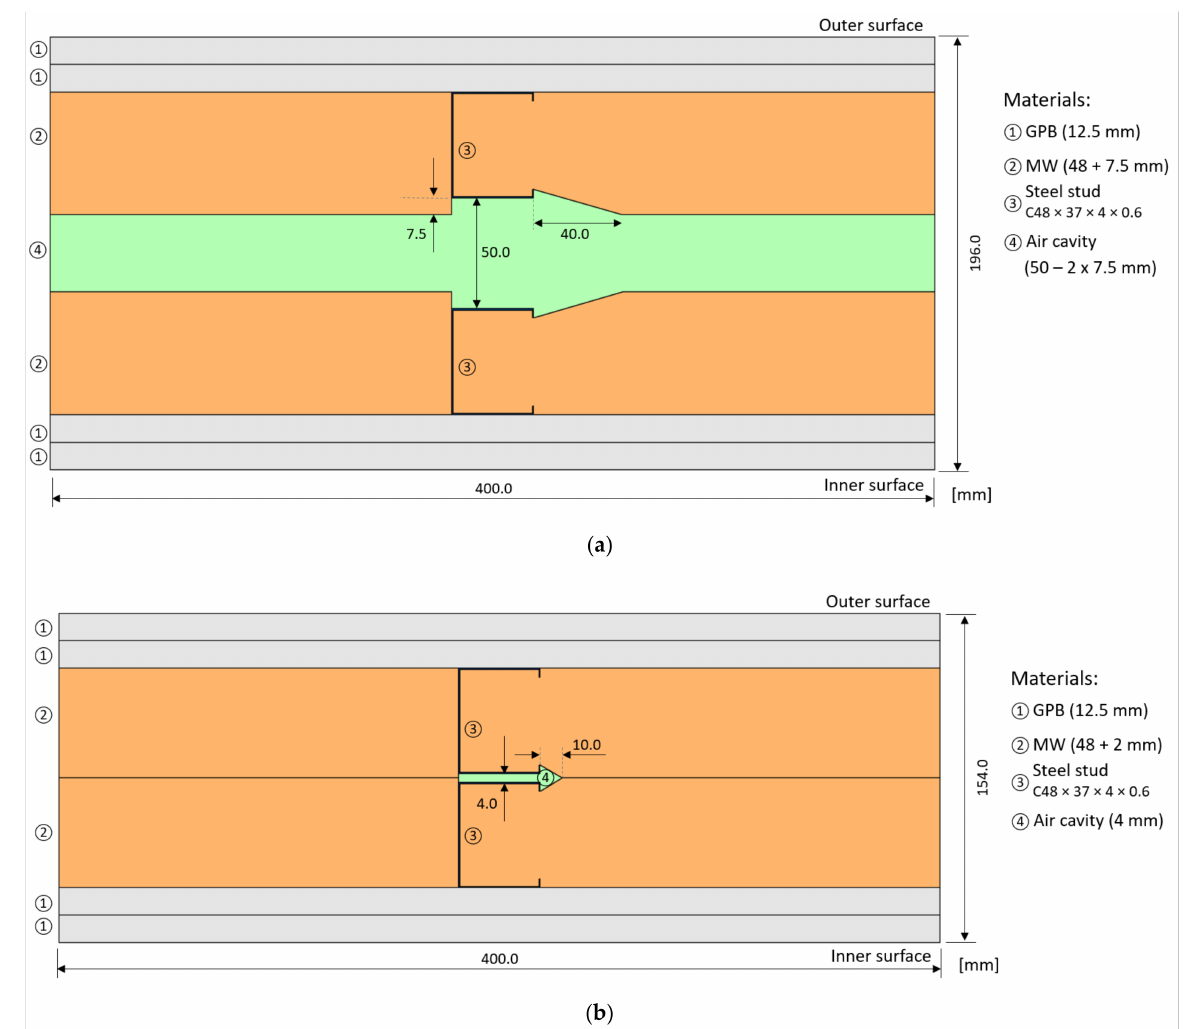
Figure 5. Modelled geometry and used materials for the double pane LSF walls. ( a ) Nominal 50 mm air cavity thicknesses; ( b ) Nominal 0 mm air cavity